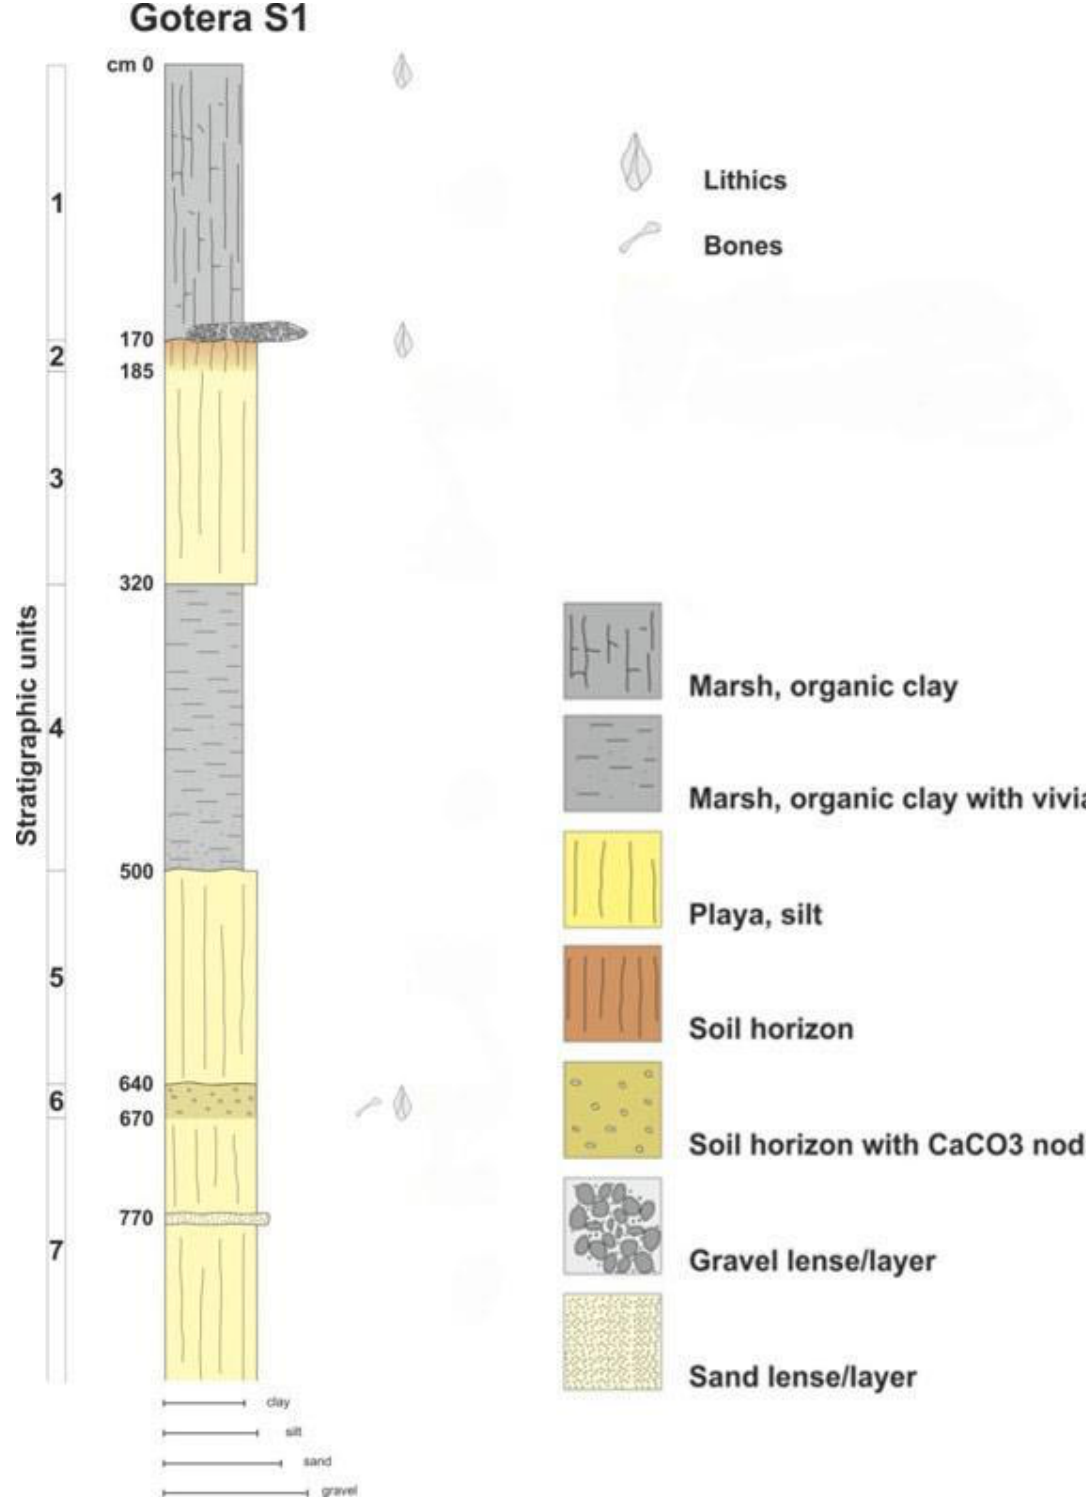
Figure 2. Schematic log representing the stratigraphic sequence of the Gotera